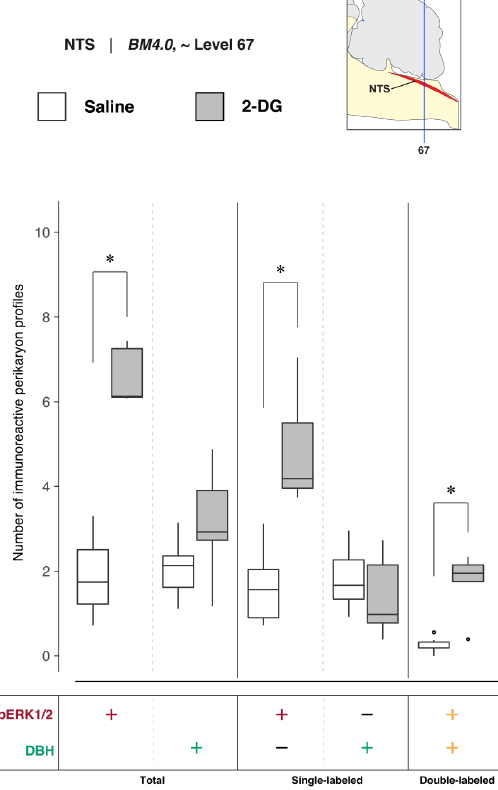
Figure 6. Increased recruitment of BM4.0 atlas level-67-registered nucleus of solitary tract (>1840) (NTS) neurons 15 min after 2-DG administration. Abercrombie-corrected [106] perikaryon profile counts from both saline- and 2-DG-treated subjects are represented as box plots displaying the total numbers of phospho-ERK1/2- or DBH-immunoreactive profiles, or only the single- and double-labeled profiles, from tissue sections identified to be in register with BM4.0 atlas level 67 (map, upper right ). An asterisk (*) denotes statistical significance between groups, FDR-adjusted p < 0.05. See Tables S4 and S5 for details. On the box plots, potential outliers are presented as open